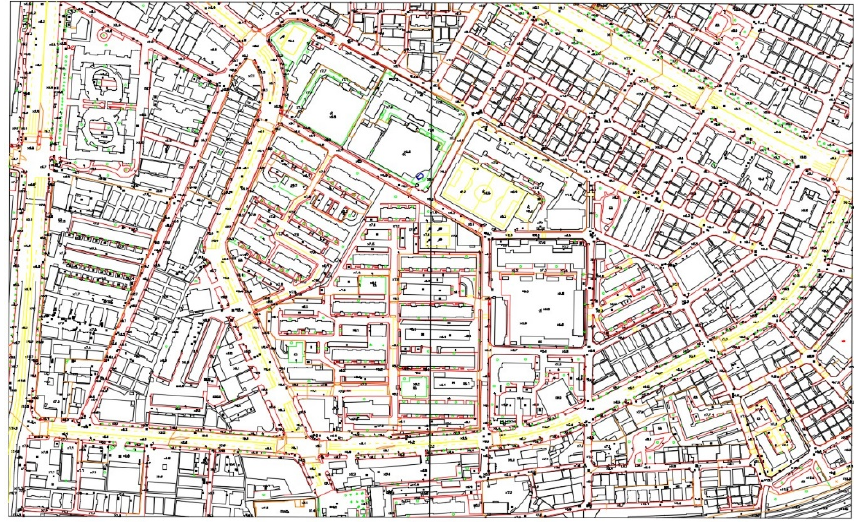
Figure 11. A digital map generated by stereoscopic plotting with most accurate pairs.